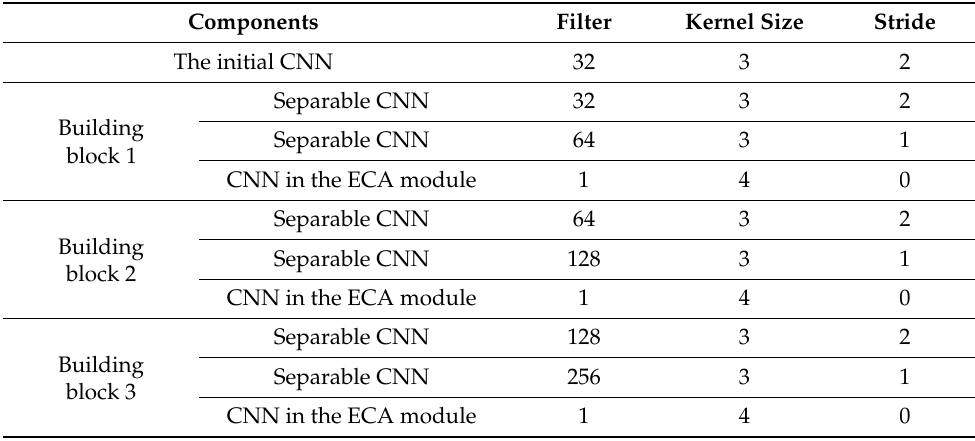
Figure 3. The architectural overview of our model. Table 2. The detailed configuration of the components in our model (shown in